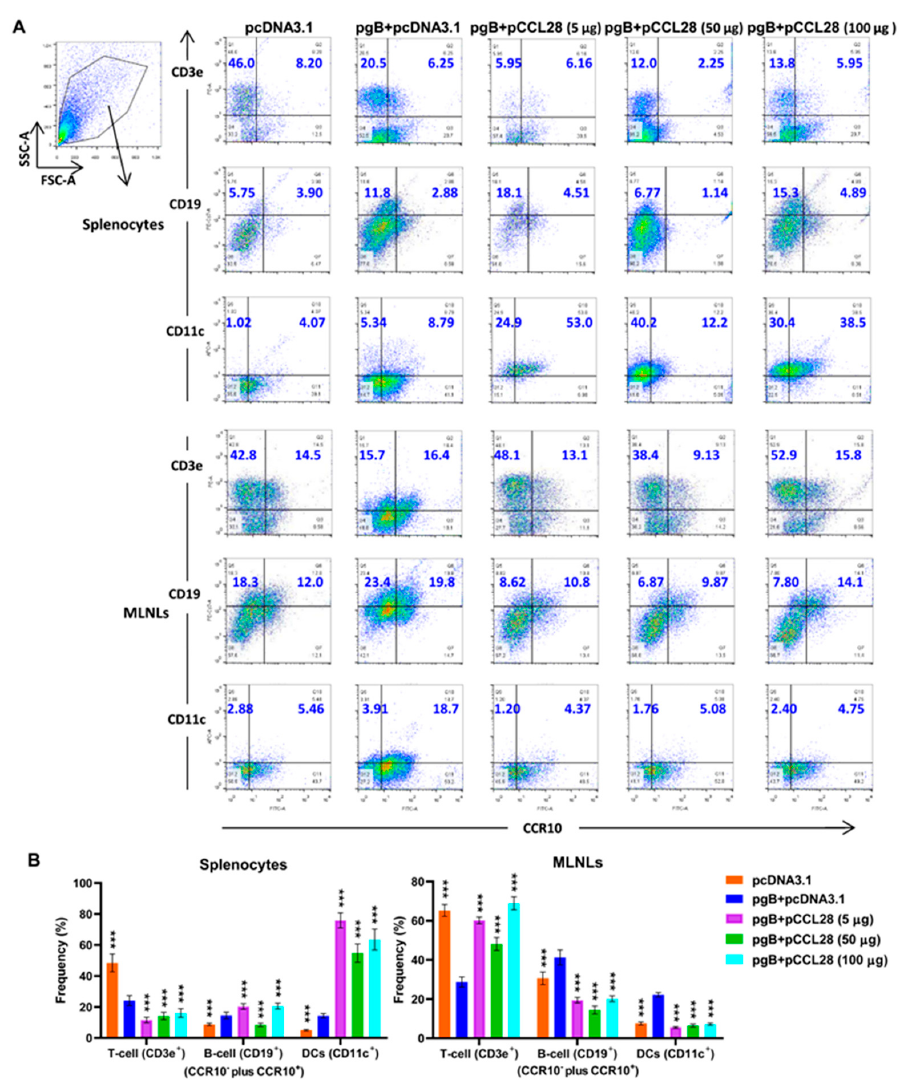
Figure 4. Comparison of gB-specific CCR10 +/ − immunocyte compositions in the spleen and mesen- teric lymph nodes. ( A ) Flow cytofluorometry graphs of splenocytes and mesenteric lymph node lymphocytes (MLNLs). On day 14 post boost, splenocytes and MLNLs (1 × 10 7 cells) isolated from various groups ( n = 5/group) were stimulated with purified gB (1 μ g/mL), and the frequencies (in percentage) of CCR10 +/ − CD3e + , CD19 + , and CD11c + immunocytes were detected by Flow cytometry assay and analyzed by FlowJo software. ( B ) Comparison of the frequencies (%) of murine CCR10 − plus CCR10 + immunocytes in each group. Data are expressed as the means of immunocyte fre- quencies (%) ± SEMs pooled from at least two independent experiments, with each condition per- formed in duplicate. Statistically significant differences were determined by comparing with the pgB + pcDNA3.1 group. *** p < 0.001; antigen group compared to control (pcDNA3.1) or pgB + pCCL28 (5, 50, or 100 μ g) group, as determined by nonparametric Student’s t -test.